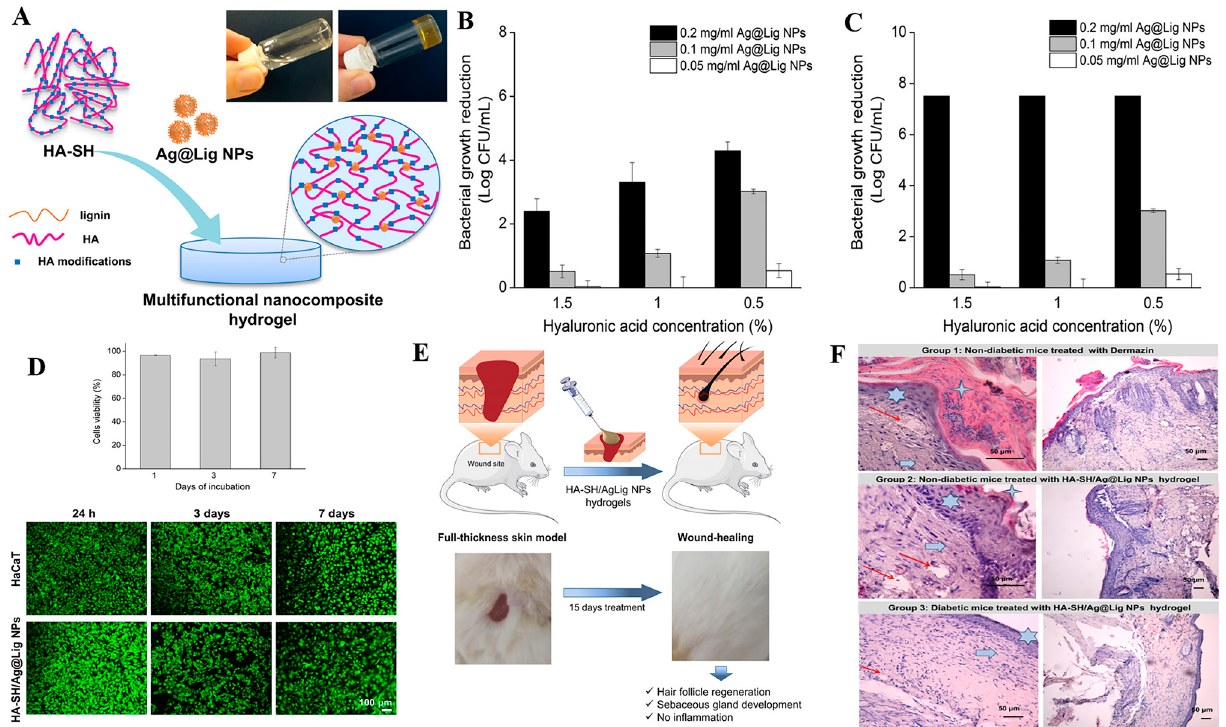
Figure 2. ( A ) Schematic representation of the preparation process and possible self-assembly mech- anism of Ag@Ligin NPs-loaded hyaluronic acid (HA) nanocomposite hydrogel. Profile of the hy- drogel’s antibacterial activities against ( B ) Staphylococcus aureus and ( C ) Pseudomonas aeruginosa . ( D ) Viability of keratinocytes after 1, 3 and 7 days coculture with the Ag@Lig NPs-loaded hydrogel. ( E ) Representative images of full-thickness skin wounds in a mouse model before and after application of the nano-enabled hydrogels. ( F ) Hematoxylin-eosin-stained sections of wound tissues across dif- ferent treatments. Reproduced with permission from ref [59], Copyright 2021 Elsevier .